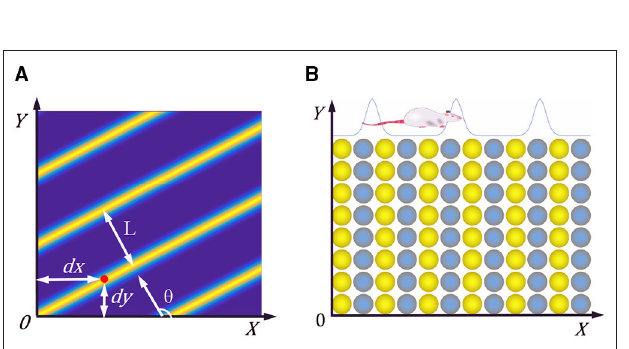
FIGURE 2 | (A) Firing characteristic parameters of stripe cells. (B) Neural plate of stripe cells, neighboring neurons have synaptic connections in the X -axis direction, but not in the Y -axis direction.